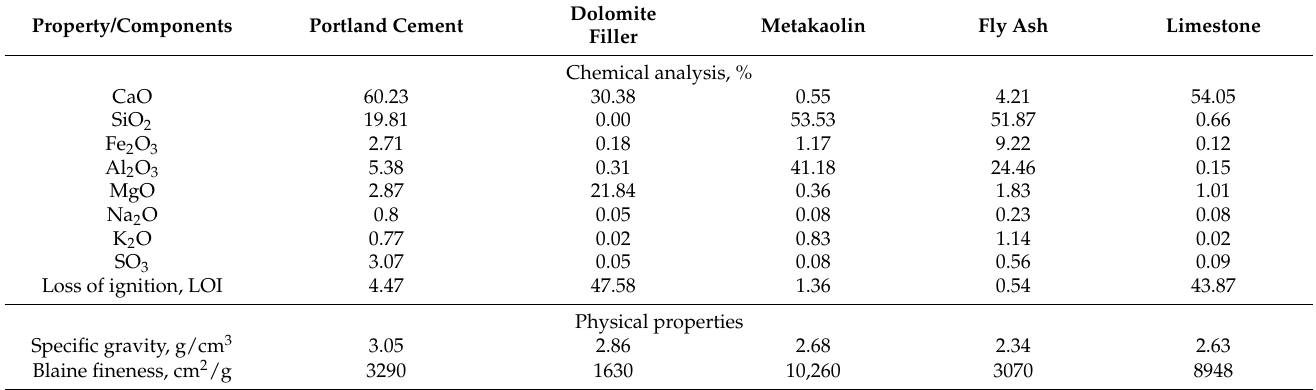
Figure 2. TG/DTA graph of dolomite aggregates. 2.2. Concrete Mix Design and Specimen Dimensions The details of the studied concrete mixes are provided in Table 2. CEM I 42.5 R was used as the binder in the reference mix, M2. In the other nine mixes, M3 – M11, the mineral additives, metakaolin (MK), fly ash (FA) and limestone filler (LF) were used as partial replacement for cement by weight. All concrete mixes were designed to achieve a slump flow of 700 ± 50 mm. Other fresh concrete properties required for SCC mixes were also tested to ensure good flowability, workability and segregation resistance of the tested mixes and are also listed in Table 2. All mixes met the requirements for SCC according to EFNARC [27] and EN 206-9 [28].